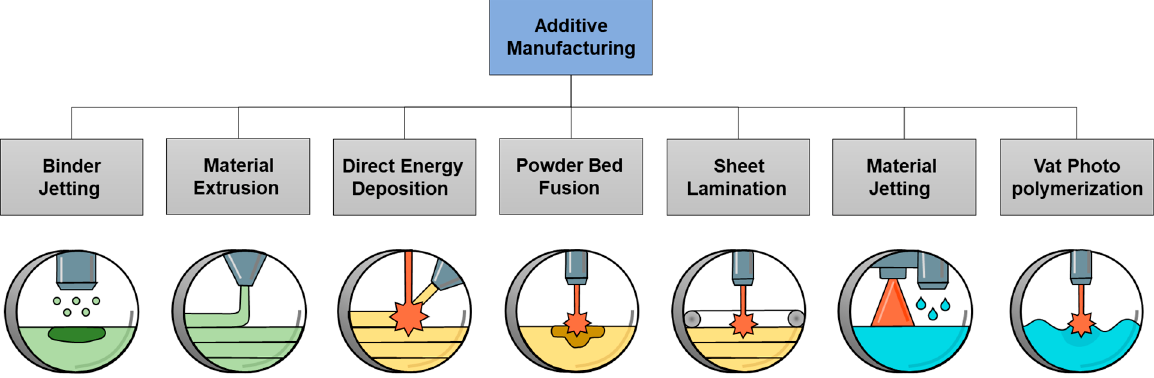
Figure 2. Main types of additive manufacturing (AM) processes according to ASTM F2792—12a.